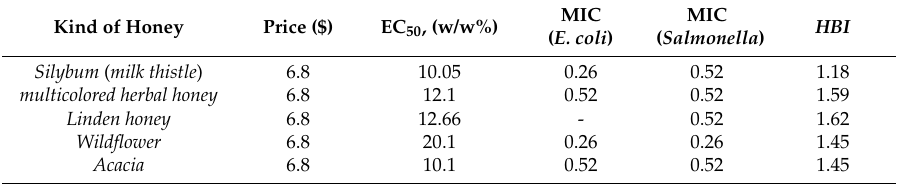
Table 3. Commercial Bulgarian honey types, prices, and antioxidant and antimicrobial activity.